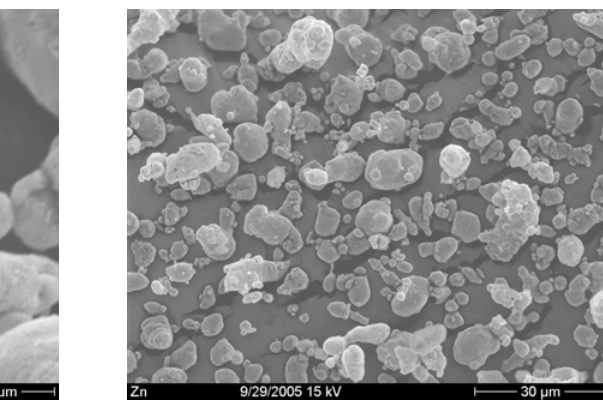
Figure 2. Zn powder, mechanical stirring.